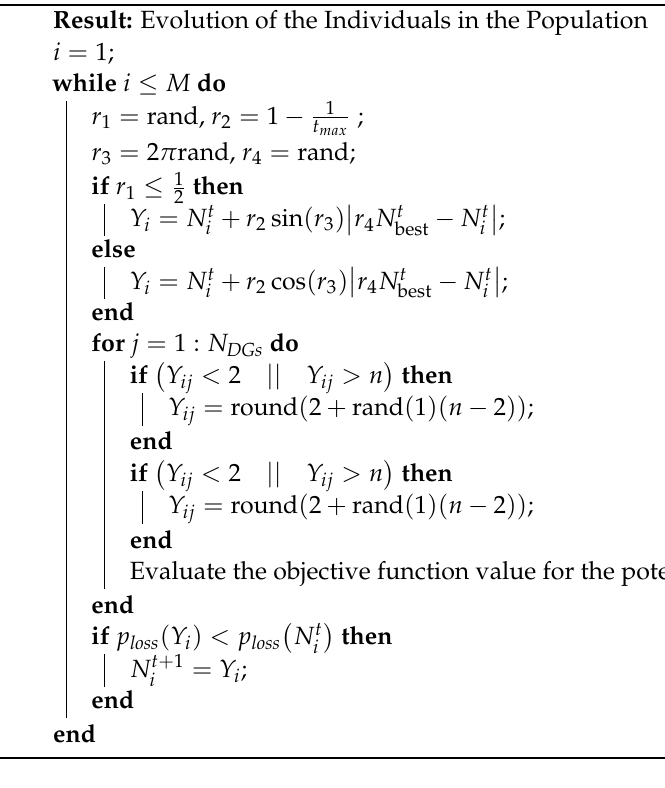
Algorithm 1: Evolution steps in the sine–cosine algorithm (SCA).